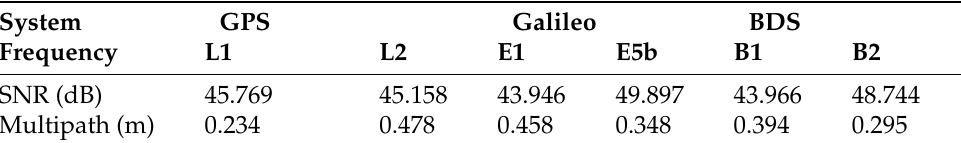
Table 2. Mean SNR and multipath errors of each GNSS signal from 10 September to 20 Septem- ber